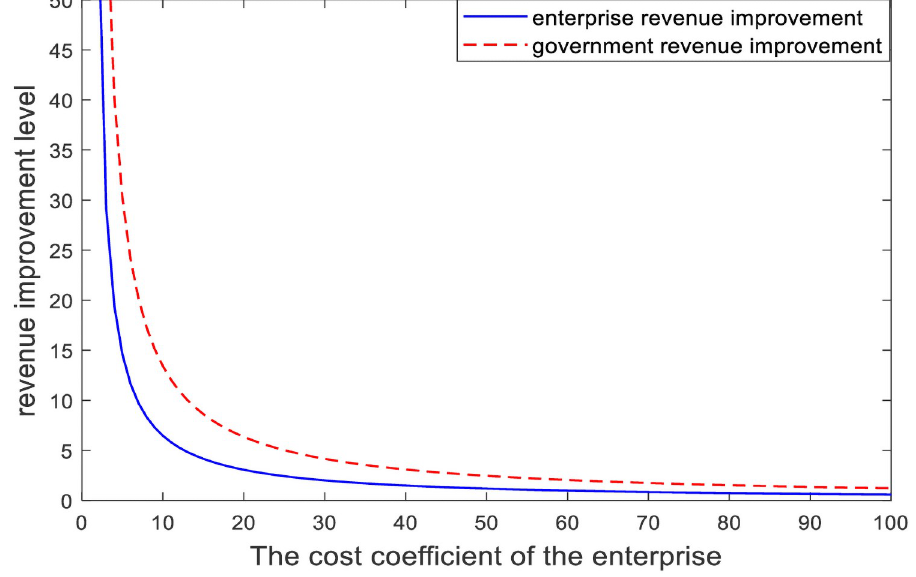
Fig 5. Influence of parameters on cost sharing improvement